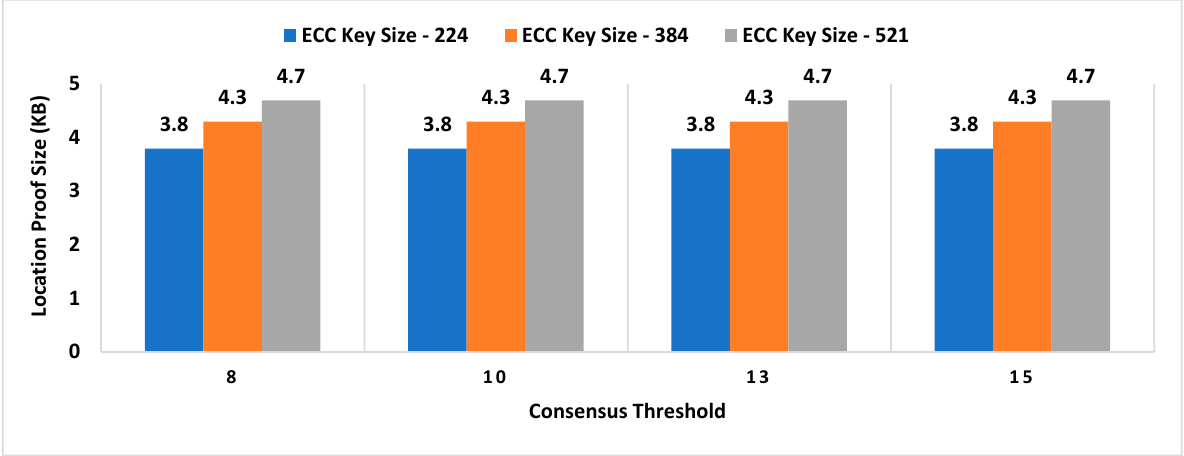
Figure 10. Consensus threshold and key size impact on location proof size.